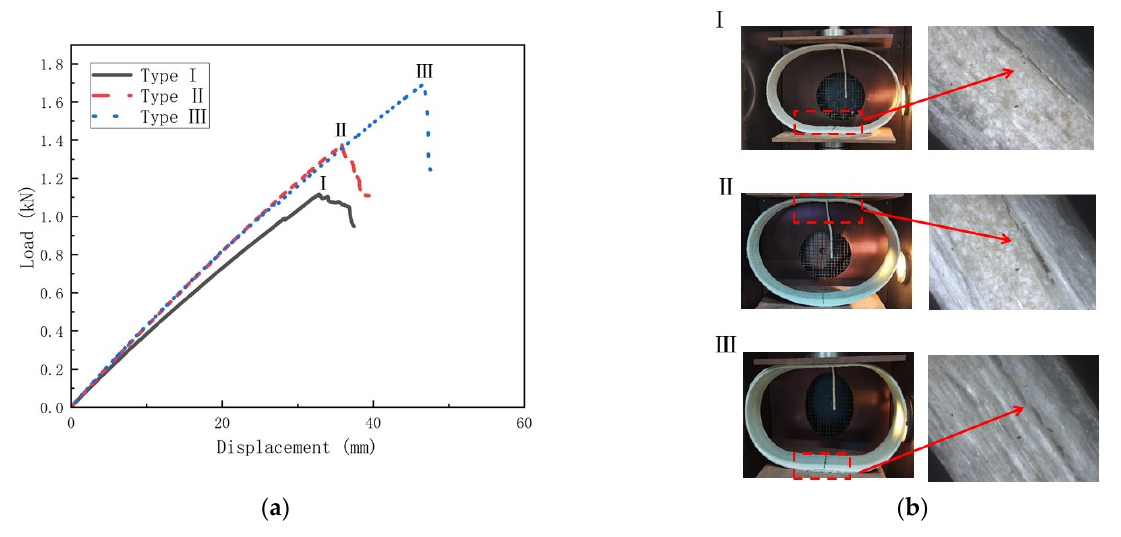
Figure 15. Load–displacement curves and failure mode diagrams for different types of GFRP pipes